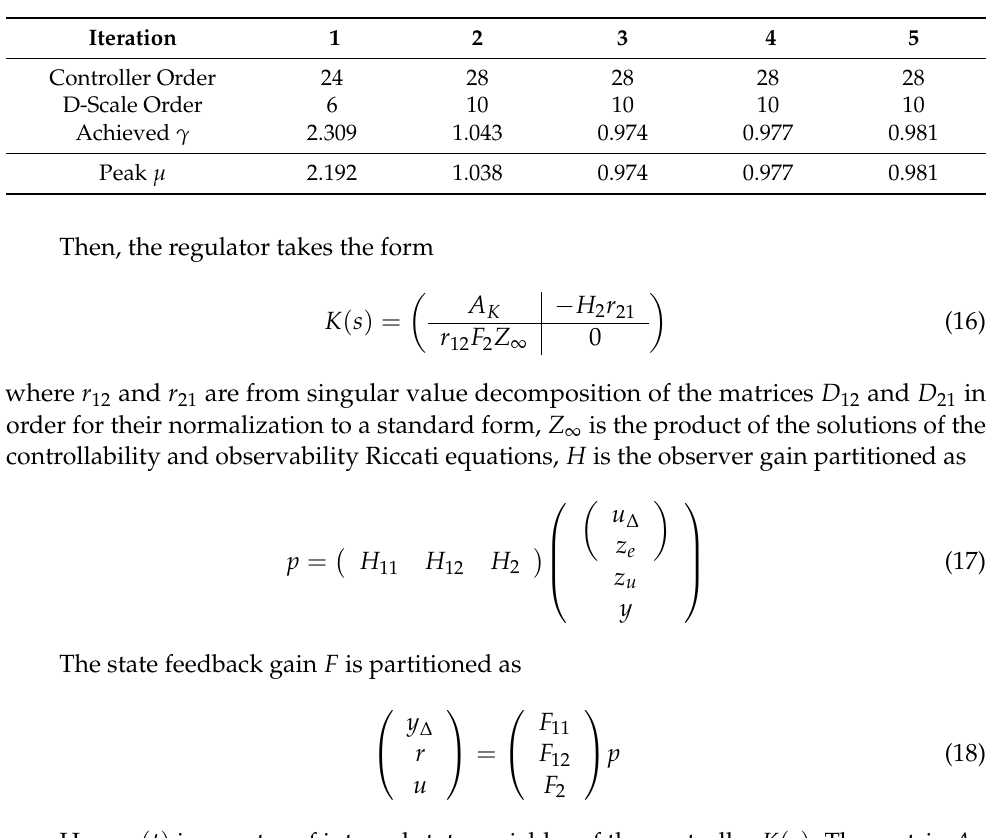
Table 1. A summary of the DK-iterative